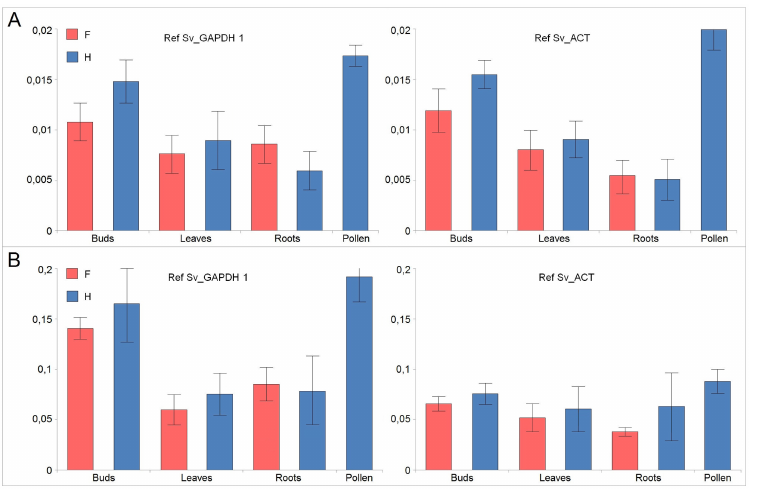
Fig 3. Relative expressionof the MSH 1 gene. Vegetative organs and pollenof S . vulgaris were normalized with SvGAPDH 1 or Sv_ACT primer pairs. A : Oligo(dT)-primed cDNAs. B : Randomhexamer-primed cDNAs. Results from three independent measurements are presented with mean values and